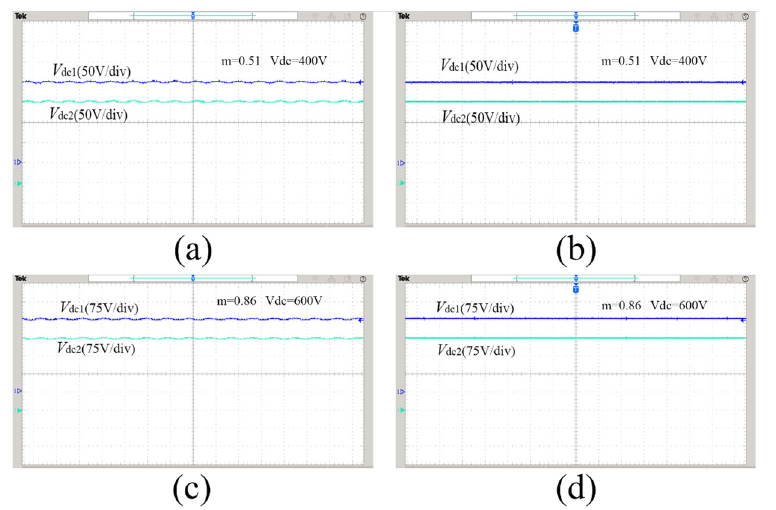
Figure 17. Midpoint potential difference experimental waveforms: ( a ) traditional method, m = 0.51, Vdc = 400 V; ( b ) proposed method, m = 0.51, Vdc = 400 V; ( c ) traditional method, m = 0.86, Vdc = 600 V; ( d ) proposed method, m = 0.86, Vdc = 600 V.